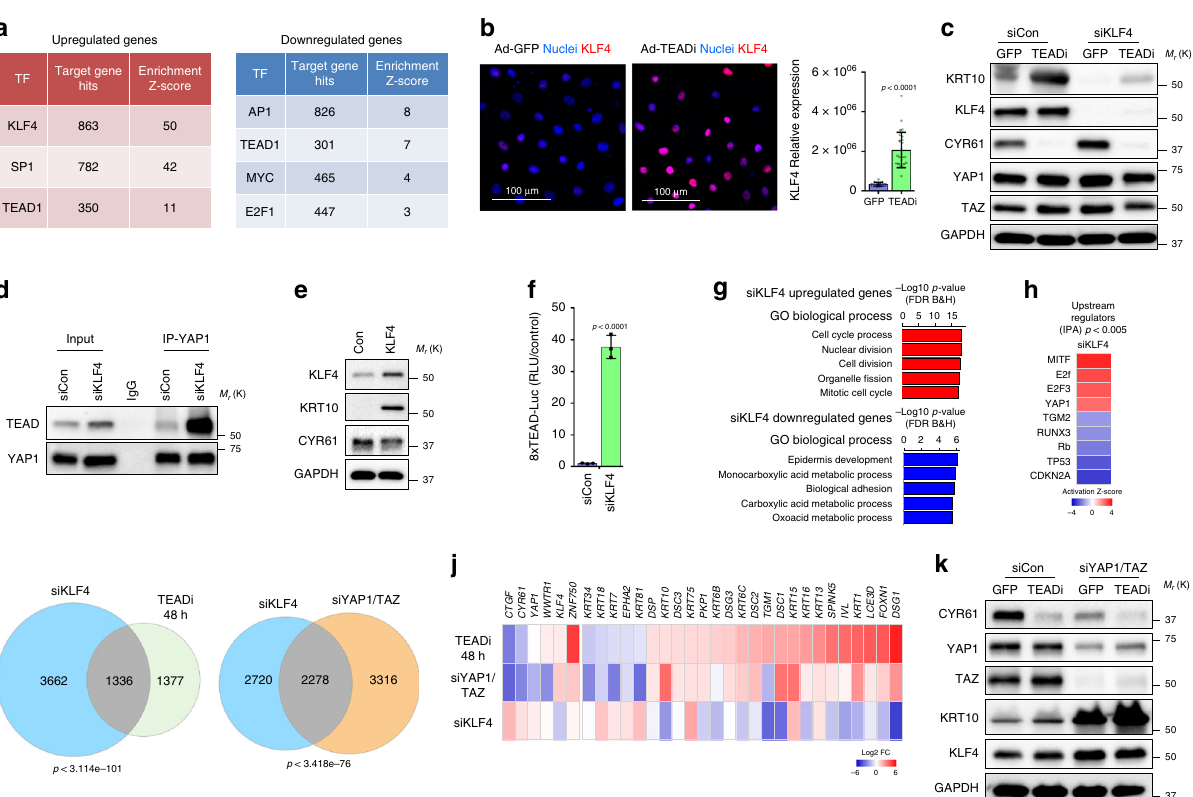
Fig. 3 Regulation of keratinocyte differentiation by TEAD and KLF4. a Selected factors found in the transcription factor binding site enrichment analysis of TEADi upregulated and downregulated gene sets. b IF staining and quanti fi cation showing the expression of KLF4 in N/TERT2G cells following transduction with GFP (Ad-GFP, control) or TEADi (Ad-TEADi) for 48 h. c Western blot analysis of expression of indicated markers in N/TERT2G cells transduced with pooled siRNAs for KLF4 for 24 h and GFP (Ad-GFP, control) or TEADi (Ad-TEADi) for additional 48 h. d Coimmunoprecipitation experiments in N/TERT2G keratinocytes transduced with pooled siRNAs for KLF4 for 48 h. e Western blot analysis in N/TERT2G keratinocytes transduced with lentiviruses expressing GFP or KLF4 for 48 h. f Transcriptional activity of TEAD measured by luciferase assay with a reporter containing tandem TEAD-binding sites in HEK293 cells transduced with pooled siRNAs for KLF4 for 48 h. g Graph indicating the GO biological process terms enriched in upregulated ( q < 0.05, FC ≥ 1.5) and downregulated ( q < 0.05, FC ≤ − 1.5) genes by KLF4 knockdown (siKLF4) in N/TERT2G keratinocytes. h Selected upstream transcriptional regulators for genes in g generated using IPA. i Venn diagrams showing the gene number overlap of differentially regulated genes ( q < 0.05, |FC| ≥ 1.5) between the indicated datasets in N/TERT2G keratinocytes. j Graph indicating the fold change (Log2 FC) of genes related to keratinocyte differentiation in the indicated datasets. Only differentiation genes differentially regulated in the TEADi 48 h dataset are shown. k Western blot analysis in N/TERT2G keratinocytes treated with or without siYAP1/TAZ and then transduced with adenoviruses expressing GFP or TEADi. In b n = 27 fi elds from 3 biological replicates, ( f ) n = 3 biological replicates. Mean± SD is shown; two-tailed unpaired t test. In ( i ) p indicates the p -value of the overlap in Venn diagrams, Fisher ’ s exact test. Source data are provided as a Source Data fi